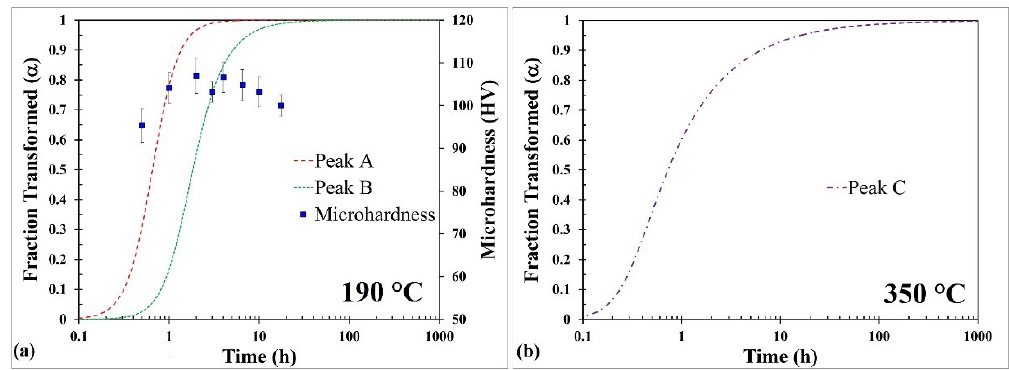
Figure 6. Isothermal evolution of the fraction transformed α in the AlSi7Cu3.5Mg0.15 (Mn, Zr, V) alloy as calculated with the LKSZ kinetic equation ( a ) for peaks A and B at 190 °C associated with microhardness results during aging, and ( b ) for peak C at 350 °C.